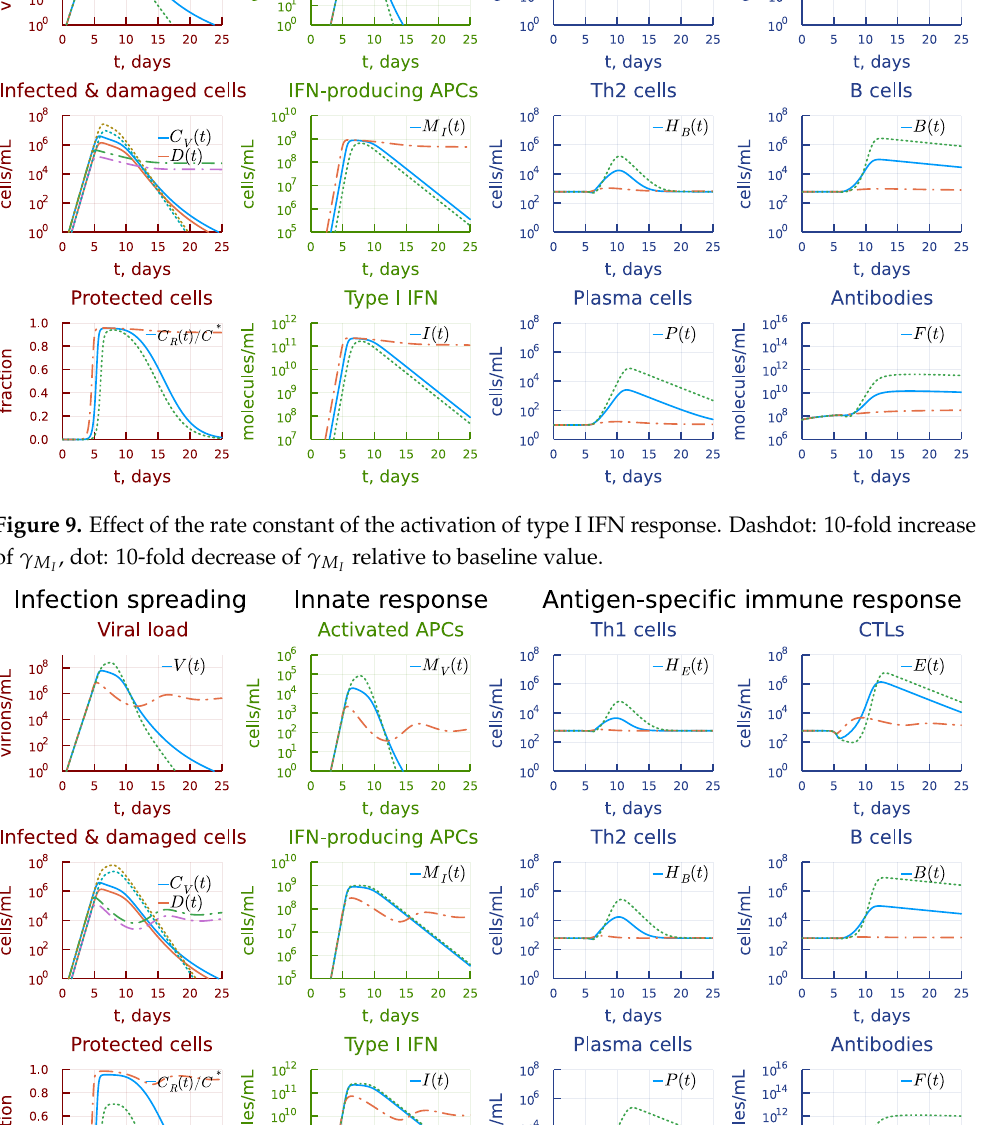
Figure 10. Effect of the rate constant of type I IFN-mediated induction of resistance to infection of target cells. Dashdot: 10-fold increase of σ R , dot: 10-fold decrease of σ R relative to baseline